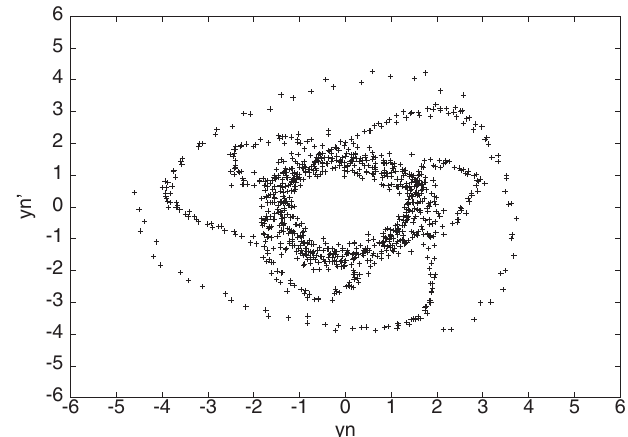
FIG. 20. Normalized vertical phase space without compensa- tion.